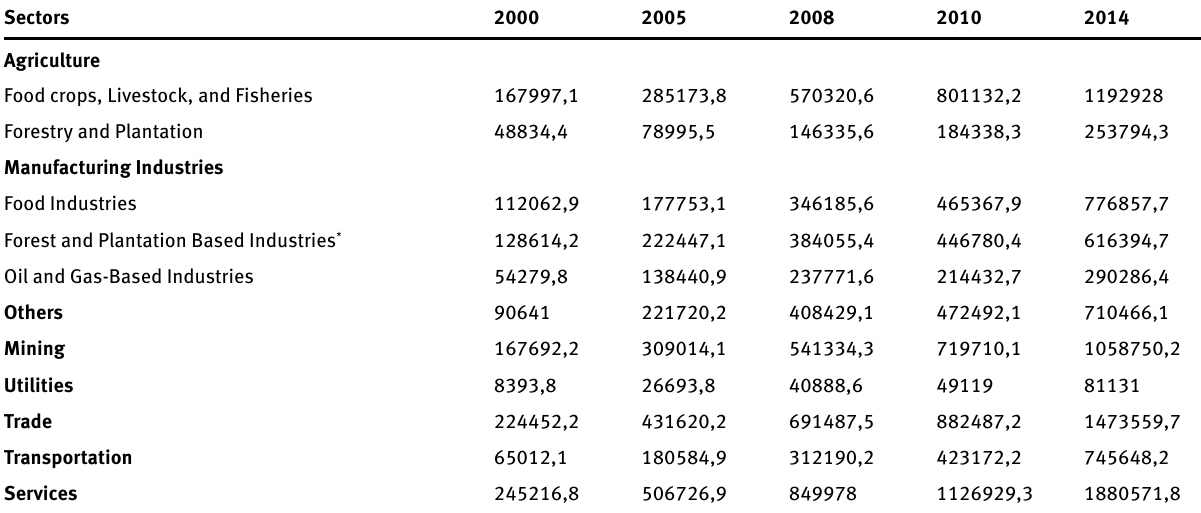
Table 2: Indonesia GDP based on Economic Sectors 2000-2014 (Billion Indonesian Rupiah (IDR)) Sectors